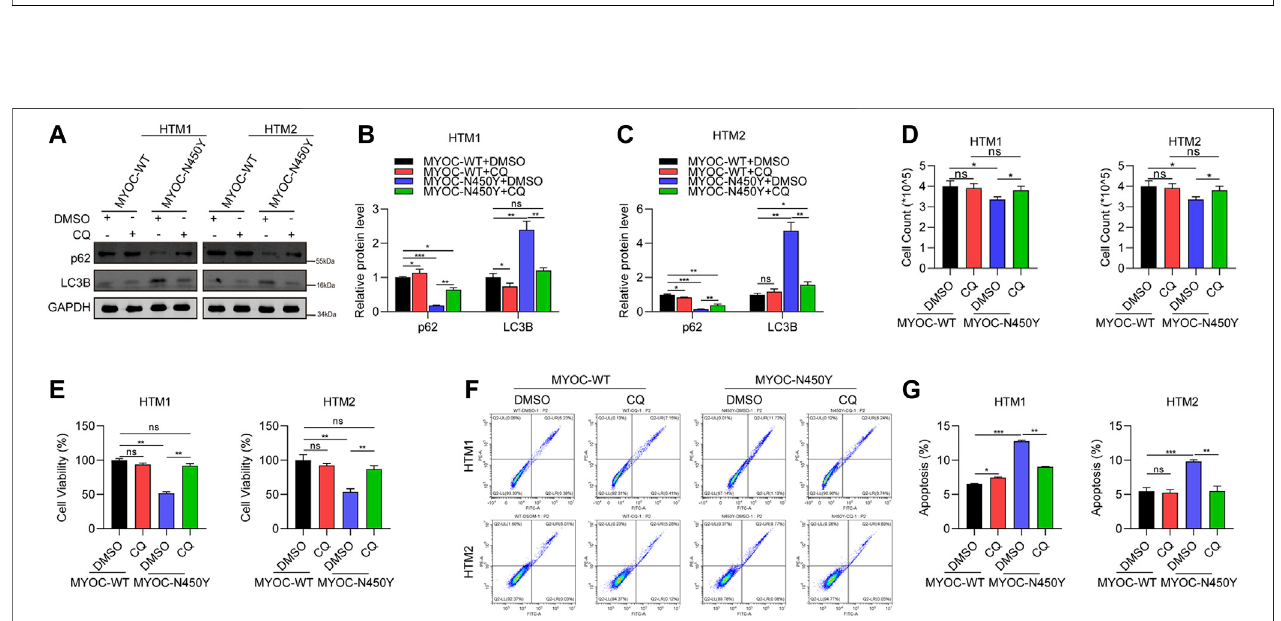
FIGURE 3 | Autophagy inhibition rescues HTM cell viability and apoptosis (A) Western blot detection of P62, LC3B and GAPDH with or without chloroquine treatment. (B,C) Band intensity analysis in (A) using ImageJ software. *, p < 0.05; **, p < 0.01; ***, p < 0.001; ns, no signi fi cance. (D) Cell count of HTM cells with or without chloroquine treatment. **, p < 0.01. (E) Cell viability was detected using CCK8 inHTM cells with or without chloroquine treatment. (F) Flow cytometry analysisof apoptosisofHTMcellsindifferentgroups. (G) ApoptosisratioanalysisofHTMcellsindifferentgroups.ns,nosigni fi cance;**, p < 0.01;***, p < 0.001.Empty:empty vector lentiviruses; MYOC-WT: lentiviruses expressing wild type myocilin gene; MYOC-N450Y: Lentiviruses expressing N450Y mutant myocilin gene.